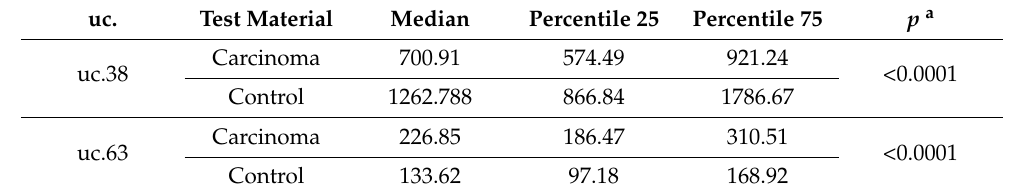
Table 5. Expression of uc.38 and uc.63 in breast ductal carcinoma patients and control.